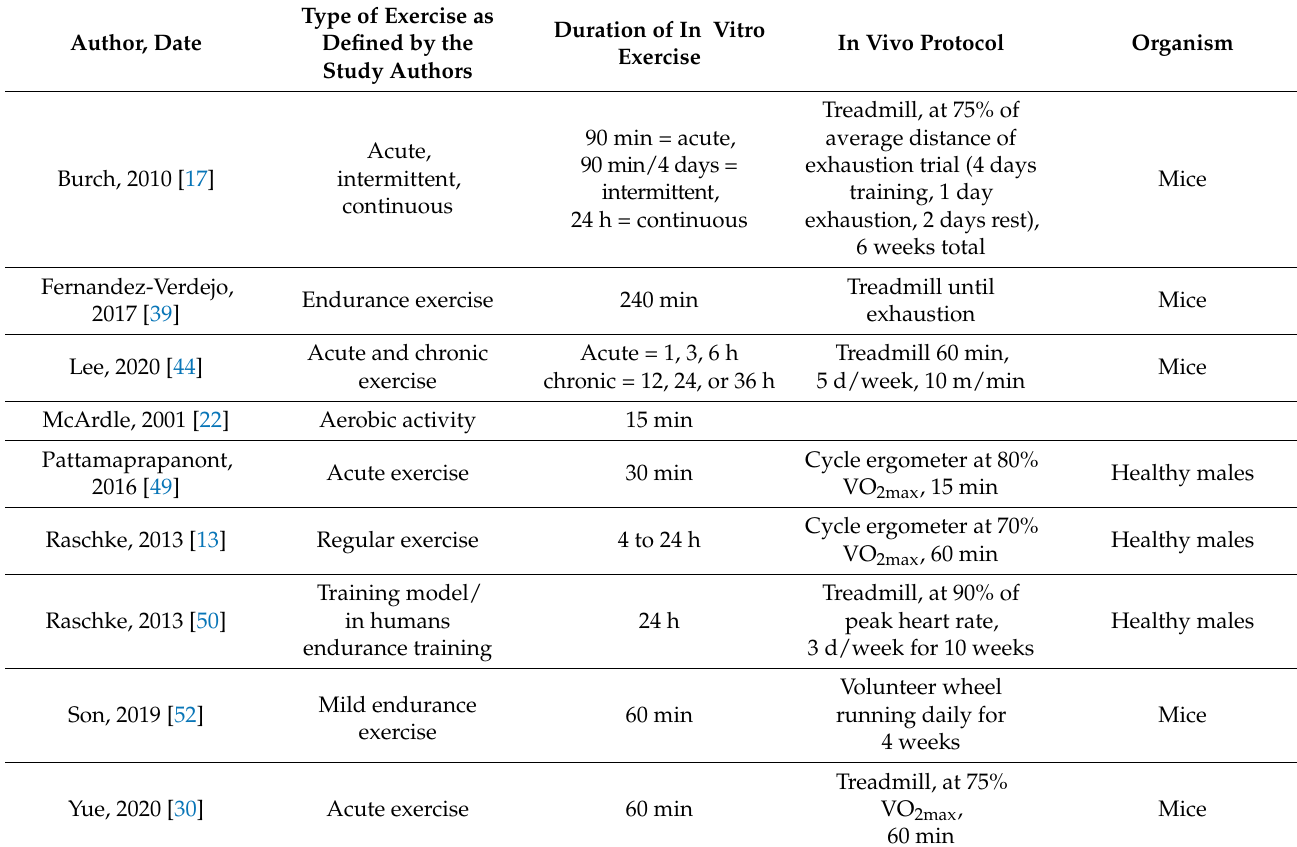
Table 1. In vitro vs in vivo studies . The type of exercise as defined by the study authors and the duration of in vitro exercise. These in vitro types of exercise have been compared directly or indirectly to in vivo models of